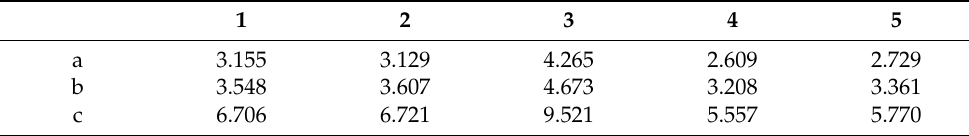
Table 2. The delivery airflow uniformity experiment of left five tubes. unit: